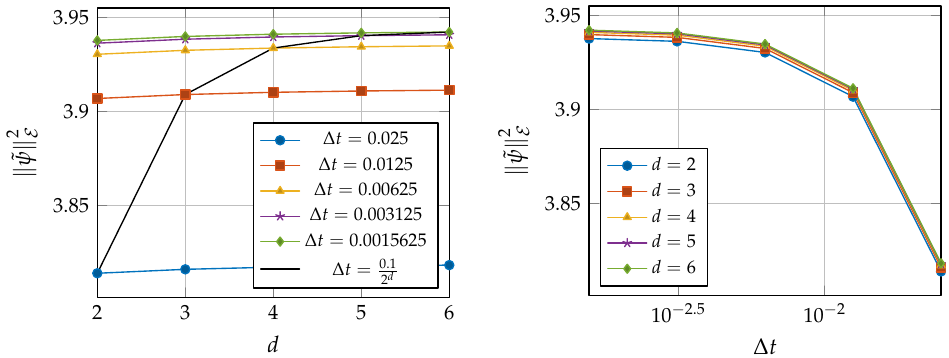
Figure 11. Squared space-time energy norm (60) of the approximated density on the segment versus increasing B-spline degree (left) and refined time discretization (right). Table 7. Space-time energy norm squared (60), varying d and fixing ∆ t = 2 − d ∆ x .